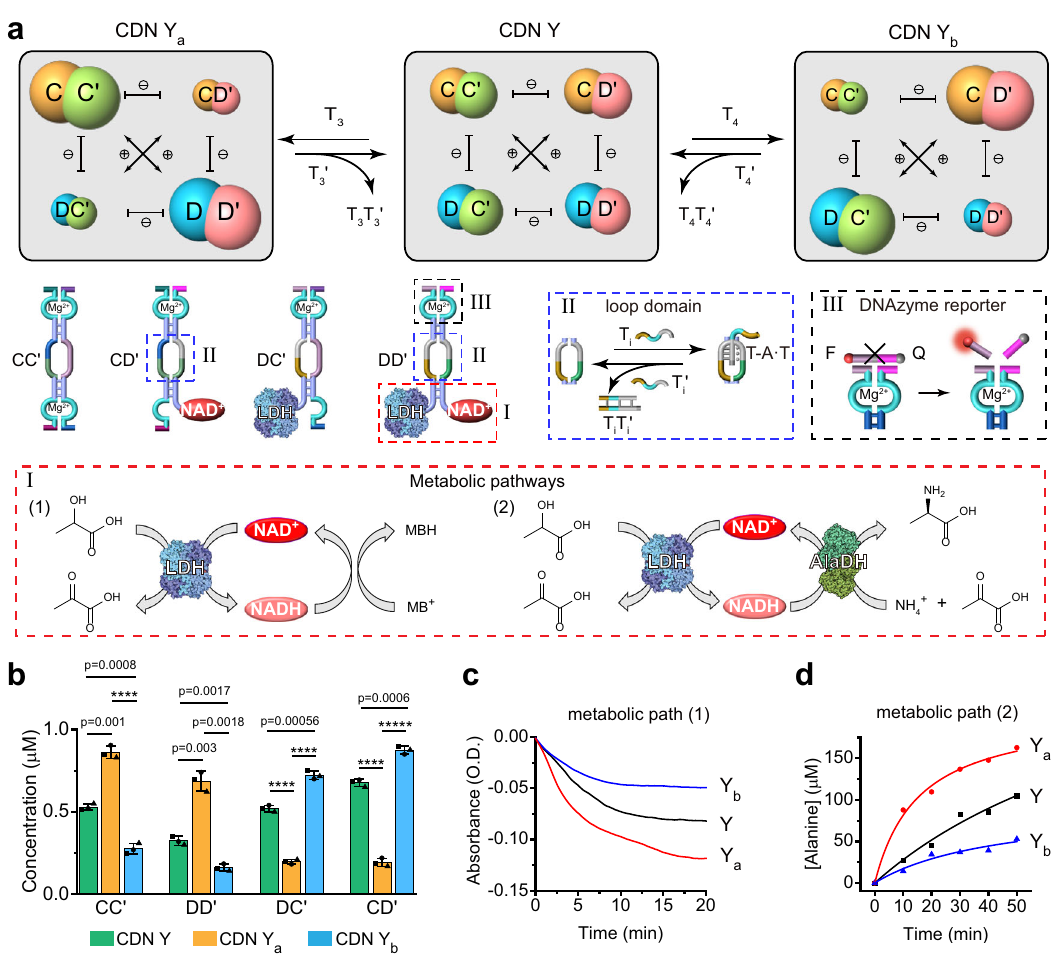
Fig. 2 Assembly and triggered recon fi guration of the metabolic network. a Schematic composition of a 2 × 2 CDN Y, its reversibly triggered recon fi guration across constitutional dynamic networks CDNs Y, Y a , and Y b , and the triggered control over metabolic paths. Panel I-Lactate dehydrogenase (LDH)-catalyzed oxidation of lactate to pyruvate and the subsequent reduction of methylene blue (MB + ) to MBH as metabolic path (1), and the subsequent alanine dehydrogenase (AlaDH)-metabolic amination of pyruvate to L -alanine, path (2). NAD + is a cofactor nicotinamide adenine dinucleotide. NADH is a reduced cofactor. Panel II-Reversibly triggered formation/dissociation of T-A · T triplex in the loop domain of a constituent. Panel III-Schematic cleavage of the fl uorophore/quencher-functionalized substrate by Mg 2 + -dependent DNAzyme reporter units associated with the constituents. b Contents of the constituents in CDNs Y, Y a , and Y b . Error bars represent mean ± s.d. based on three independent experiments. Two-sided unpaired students ’ t test, **** p < 0.0001, ***** p < 0.00001. c Time-dependent absorbance changes corresponding to the reduction of MB + to MBH by the metabolic path (1), in the presence of different CDNs Y, Y a , and Y b . d Time-dependent formation of L -alanine by the metabolic path (2) using the different CDNs Y, Y a , and Y b . For duplicate results in d , see Supplementary Fig. 15. N = 3 (for b and c ) and N = 2 (for d ) independent experiments were performed, respectively. Source data are provided as a Source Data fi A metabolic CDN . The metabolic CDN module is introduced in Fig. 2 and Supplementary Fig. 7. CDN Y is composed of the constituents CC ′ , DC ′ , CD ′ and DD ′ , where the components of DD ′ are modi fi ed with lactate dehydrogenase (LDH) and NAD + , Supplementary Figs. 2, 8. The metabolic biocatalytic transformation proceeding in CDN Y involves the LDH- biocatalyzed reduction of NAD + to NADH by lactic acid, and the concomitant formation of pyruvic acid. The biocatalyzed formation of NADH is coupled to the secondary reduction of methylene blue (MB + ) to colorless MBH, a process that allows the spectroscopy readout of the time-dependent formation of (Fig. 1g) is reduced as compared to CDN X. Fig. 1h shows the NADH (Fig. 2a, panel I). In addition, the biocatalyzed forma- time-dependent formation of NADPH at time intervals of tion of NADH and pyruvic acid is coupled to the secondary illumination of CDNs X, X a , and X b . The ef fi ciency of production reductive amination of pyruvic acid, in the presence of NH 4 + and alanine dehydrogenase (AlaDH), to form L -alanine as a of the photogenerated NADPH is controlled by the ef fi ciency of metabolic product. the primary photoinduced ET process that yields V + · .